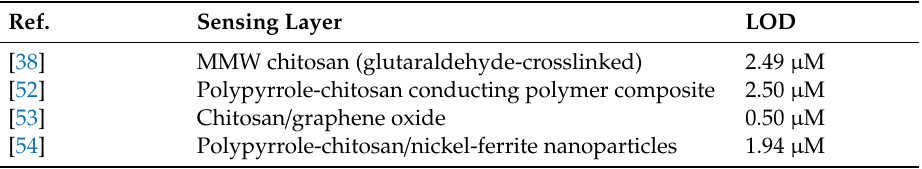
Table 1. Chitosan based material by surface plasmon resonance (SPR) for the detection of Hg 2 + .